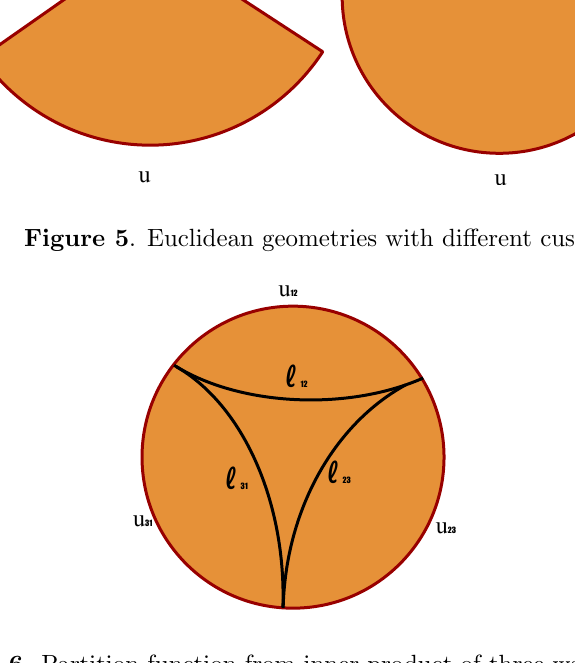
Figure 6 . Partition function from inner product of three